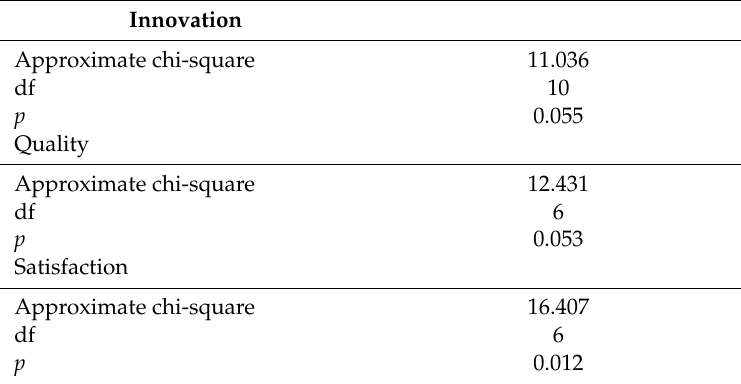
Table 1. Bartlett sphericity test.